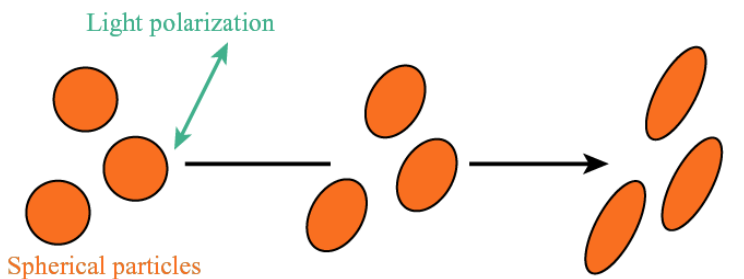
Figure 4. Deformation of azo polymer colloidal